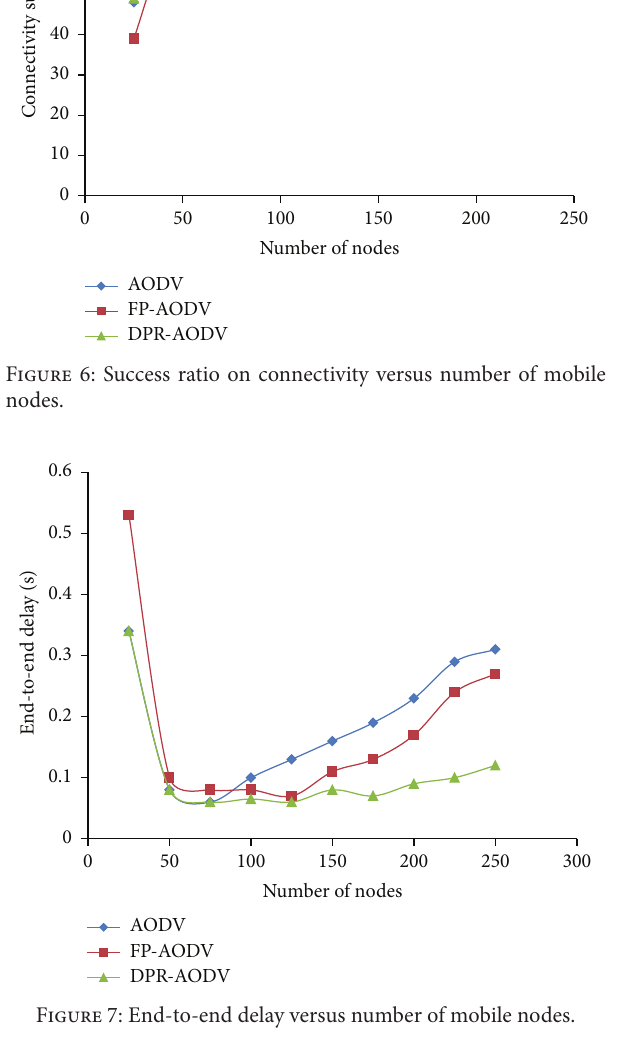
packet (RREQ) retransmission and leads to insufficient band- width for data packet transmission. Hence, there is a sudden drop of the network throughput even in the dense network.